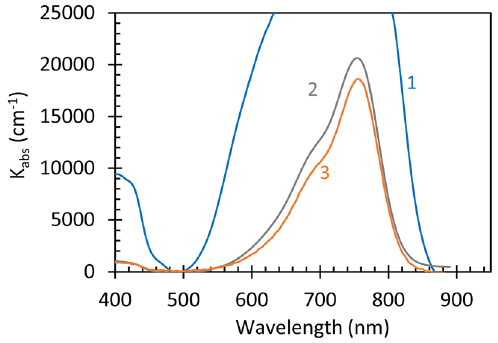
Figure 7: Absorption spectrum of the scattering 3.0 μ m HITC:PMMA fi lm(trace1),notscattering2.68 μ m fi lm(trace2),andnotscattering 0.24 μ m fi lm (trace 3). Dye concentration: ν = 40